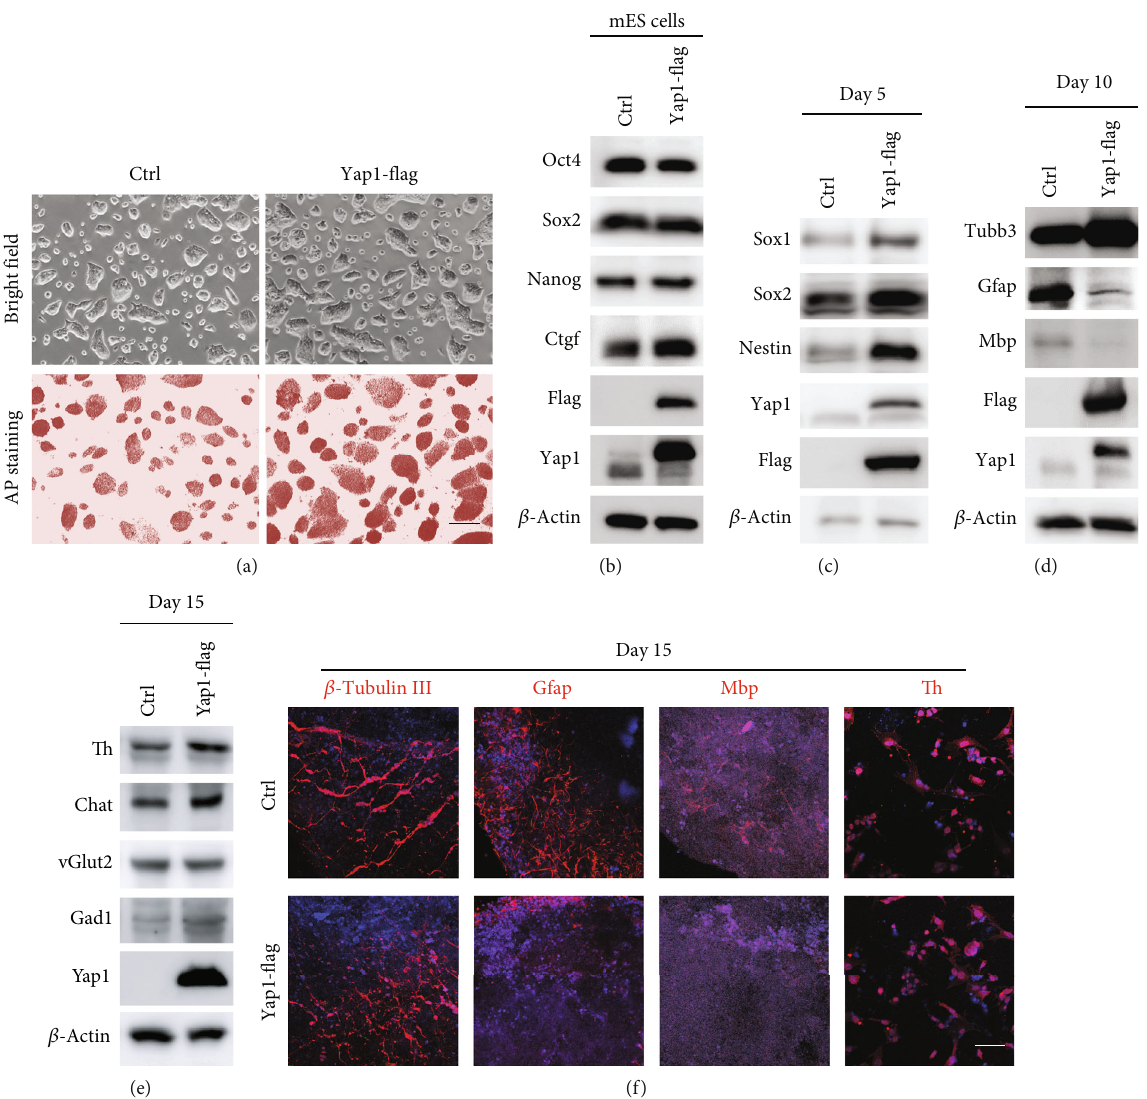
Figure 4: Yap1 overexpression in mESCs phenocopied the glial cell lineage defect di ff erentiated from Lin28a/b OE cells. (a) Phase-contrast microscopy and AP staining of Ctrl and Yap1 constitutively expressed (Yap1 OE) mouse ESCs grown under 2i +LIF medium. Scale bar, 200 μ m. (b) Western blot analyses of total proteins from Ctrl and Yap1 OE mouse ESCs using the indicated antibodies. Oct4, Sox2, and Nanog are pluripotent stem cell markers. (c) Western blot analyses of total proteins from Ctrl and Yap1 OE mouse ESC di ff erentiated cells on day 5 using the indicated neural stem cell markers: Sox1, Nestin, and Sox2. (d) Western blot analyses of total proteins from Ctrl and Yap1 OE mouse ESC di ff erentiated cells on day 10 using the indicated neuronal marker: β -tubulin III, glial markers: Gfap and Mbp. (e) Western blot analyses of total proteins from Ctrl and Yap1 OE mouse ESC di ff erentiated cells on day 15 using the indicated neuronal subtype markers: Th, vGlut2, Gad1, and Chat. (f) Immuno fl uorescence staining of the Ctrl and Yap1 OE mouse ESC di ff erentiated cells on day 15 using the neuronal marker β -tubulin III, glial markers Gfap and Mbp, and neuronal subtype markers Th. Cell nuclear was stained with DAPI. Scale bar, 200 μ